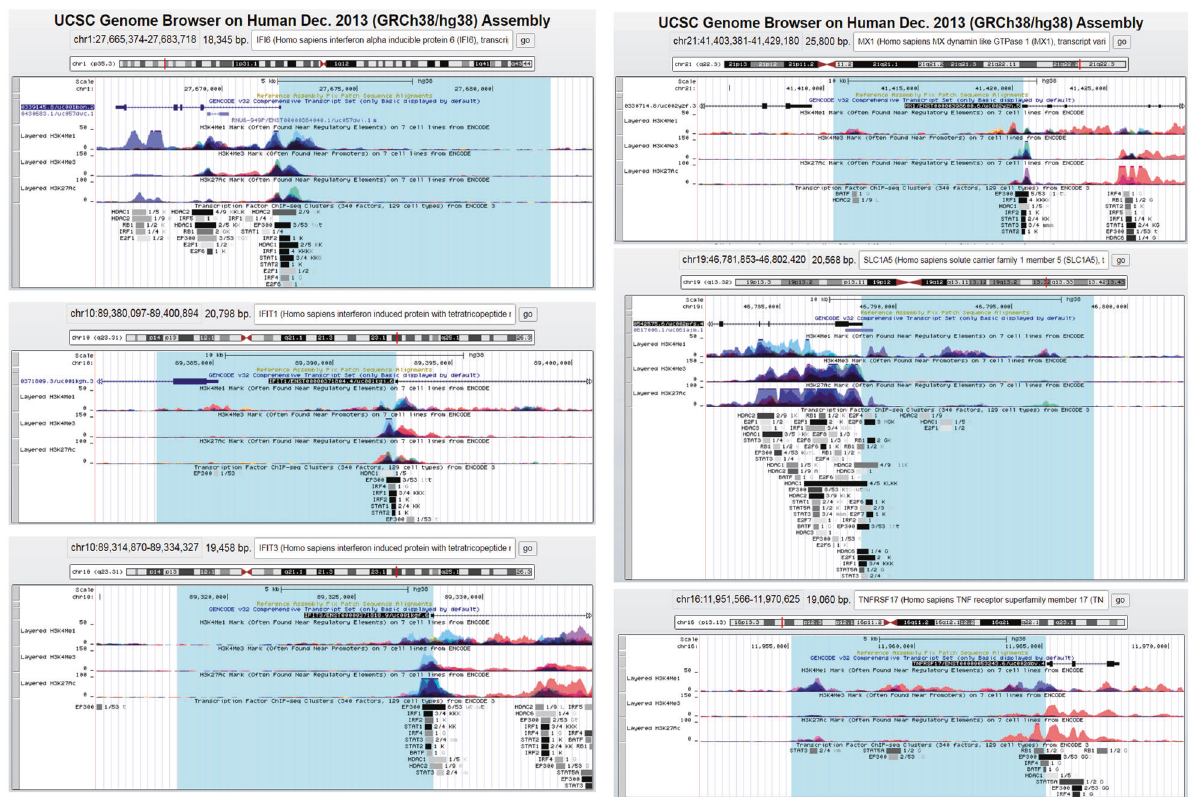
Fig. 8 UCSC genome browser ChIP-seq analysis of the 6 upregulated promoters in COVID-19 cancer patients. Analysis on IFI6, IFIT1, IFIT3, MX1, SLC1A5, TNFRSF17 promoters using UCSC genome browser and selecting available cells of blood origin (GM12878 and K562 cell line). The analysis has been performed on a region spanning 10Kb upstream TSS (highlighted in light blue) and the fi rst intron of the gene. The binding for the following transcriptional factors have been searched: BATF, E2F family, P300, GATA family, HDAC family, IRF family, RUNX family, STAT family, TEAD4, RB1. NFY, and SP1 ubiquitous factors were used as control. The H3K4me1, HeK4me3, and H3K27ac have been used to identify the euchromatin region around the start sites. The same analysis for the downregulated genes is shown in Supplementary Fig.